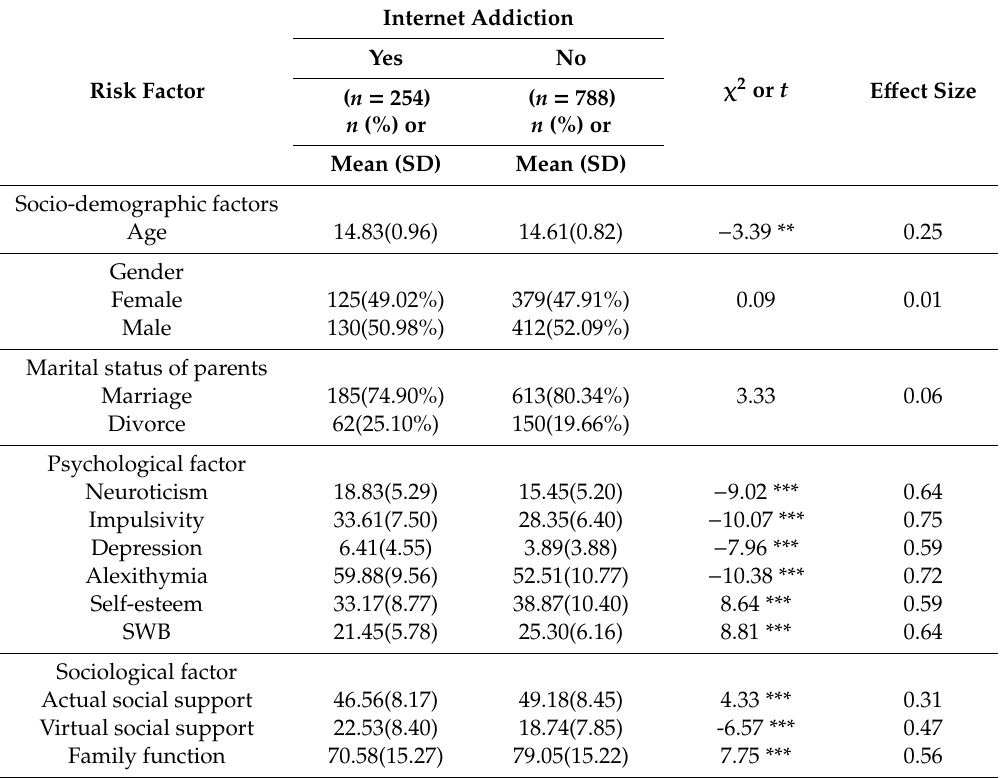
Table 1. Socio-demographic and psychosocial risk factors between the non-IA and IA groups.